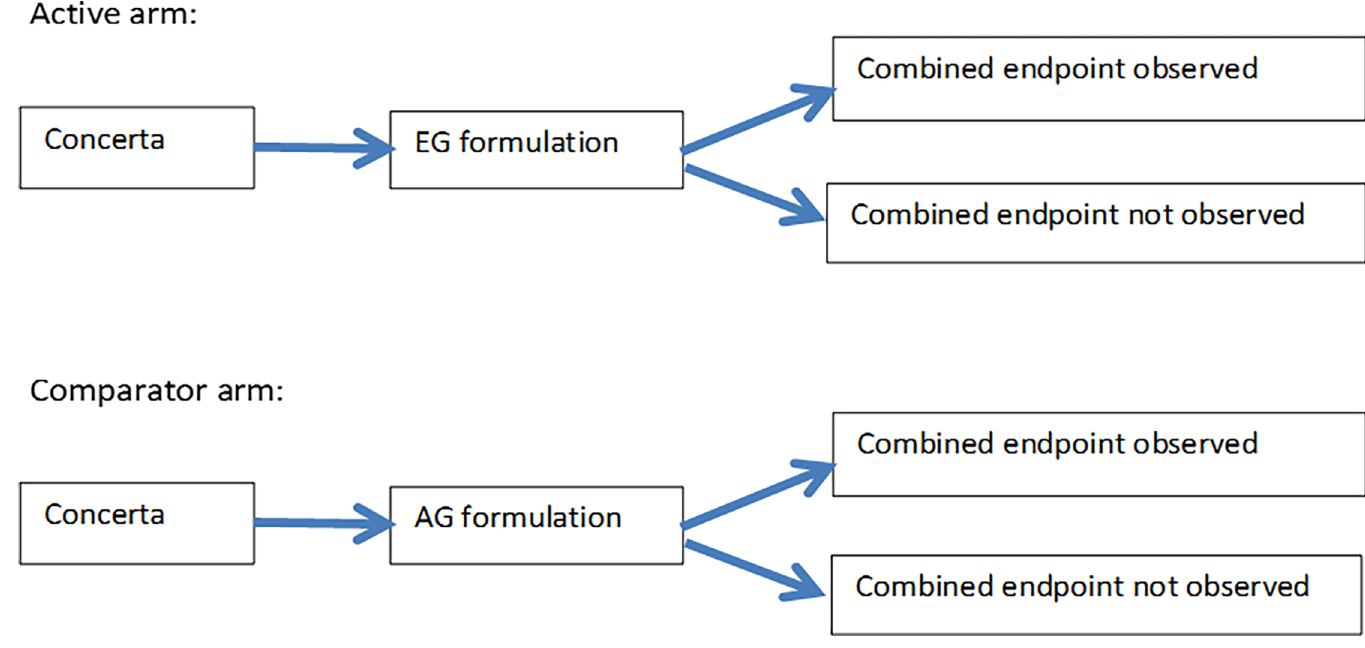
Fig 1. Schematic of study design.